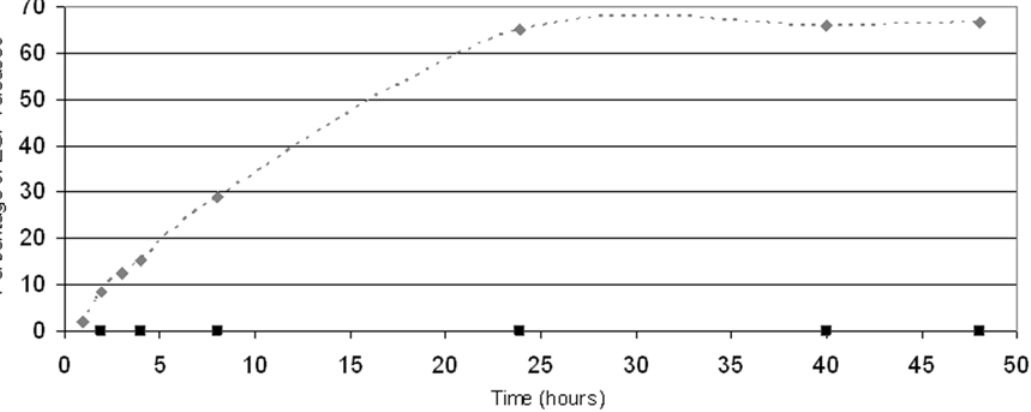
Figure 3. Percentage of EGF released from the RADA16-I gels, ( X ) when the gel is in contact with the wound, and when the gel is put in PBS ( & ).